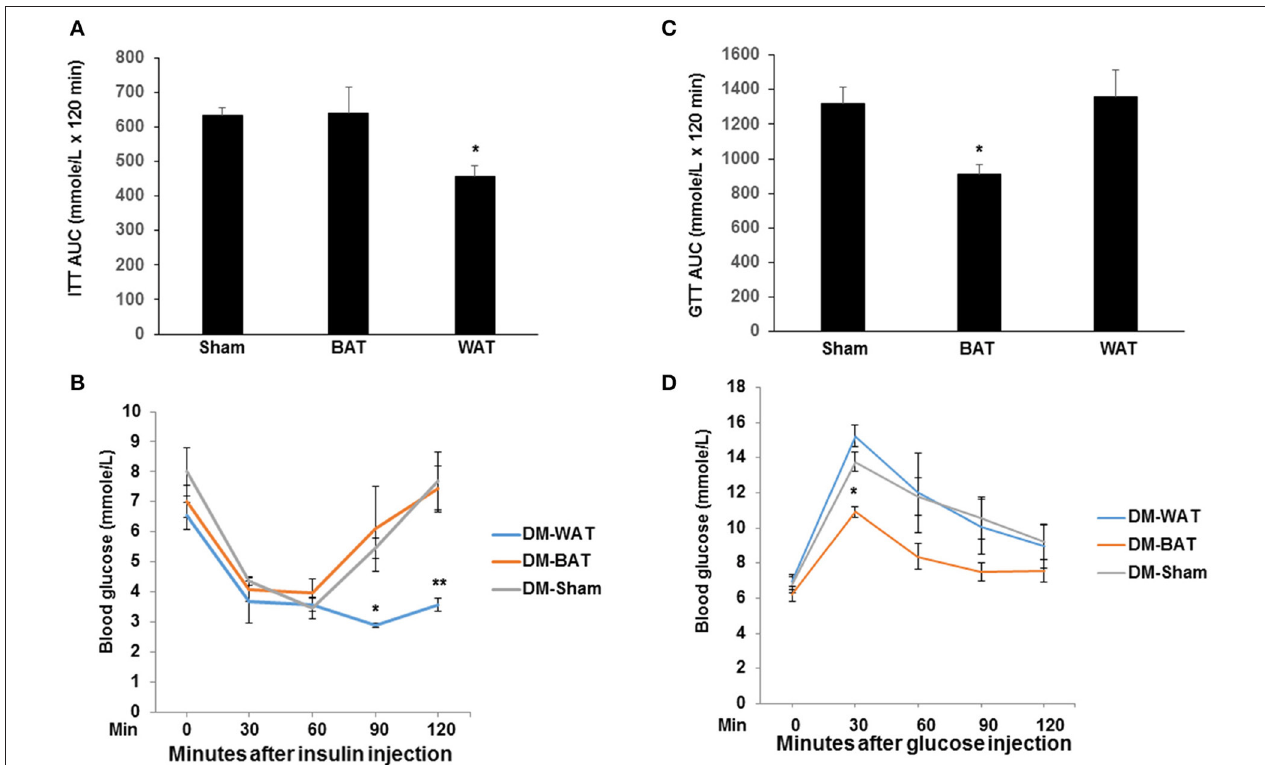
FIGURE 4 | Transplantation of WAT improves systemic insulin sensitivity and glucose tolerance. Mice were fed NCD or HFD for 14 weeks, followed by transplantation of WAT, BAT or sham-operation for 21 days. (A,B) Insulin tolerance test (ITT) and AUC in each group. n = 6 per group. * P < 0.05 vs. BAT-transplanted and sham-operated mice. (C,D) Glucose tolerance test (GTT) and AUC in the AT transplant HFD mice. n = 6 per group. * P < 0.05 vs. WAT-transplanted and sham-operated